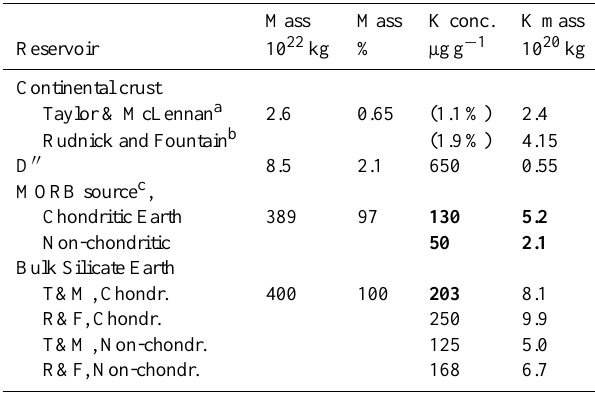
Table 6. Potassium